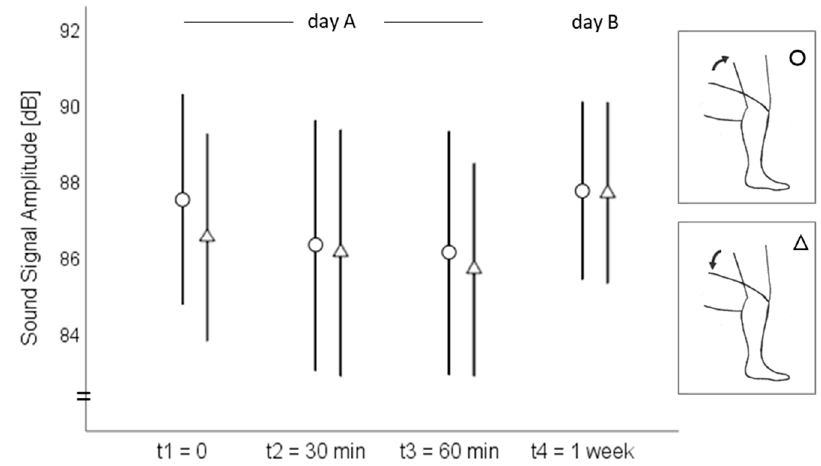
Figure 2. Means and 95% confidence intervals of the sound signal amplitude (dB) at the medial tibial plateau during standing up (circles) and sitting down (triangles).